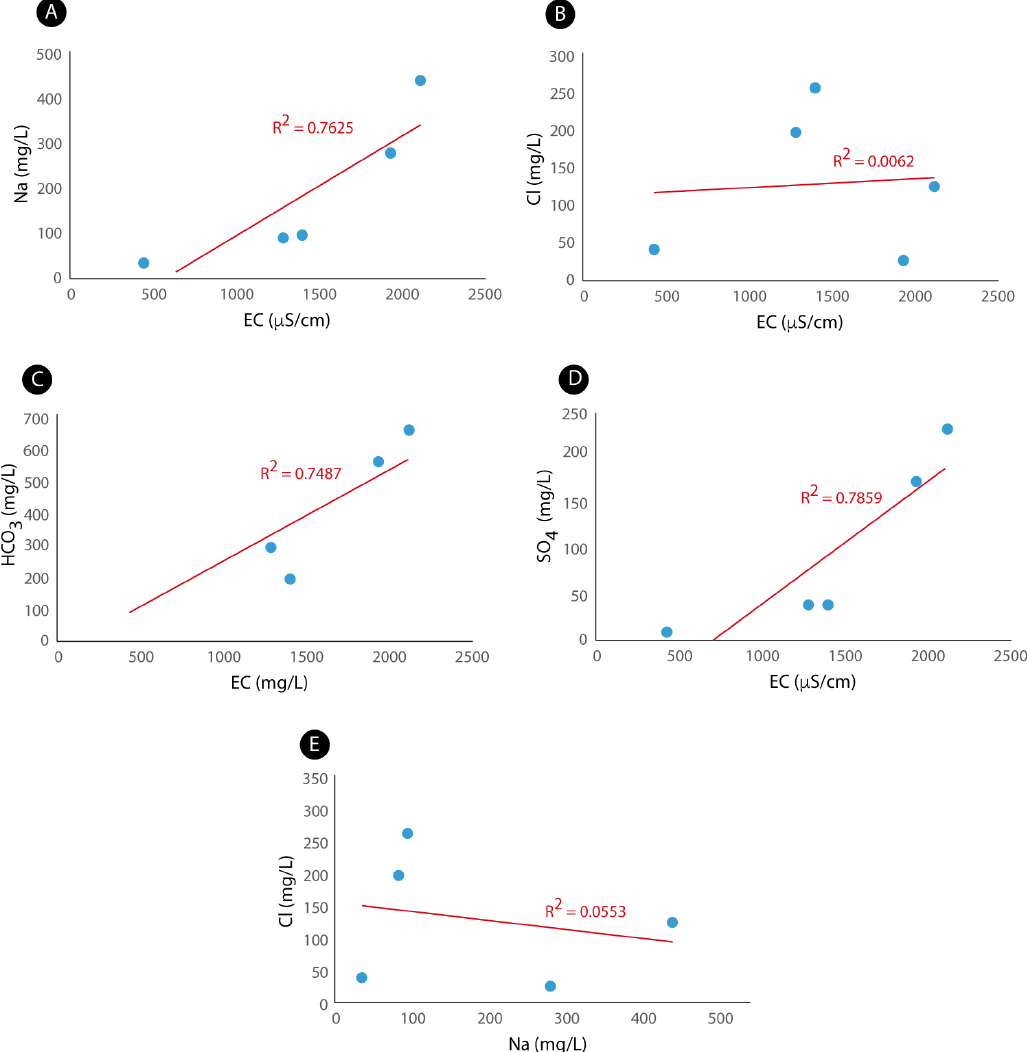
Figure 12. Relations between electrical conductivity (EC) and major ions in the S. Domingos river sub-basin. ( A ) EC–Na; ( B ) EC–Cl; ( C ) EC–HCO 3 ; ( D ) EC–SO 4 ; ( E ) Na–Cl.